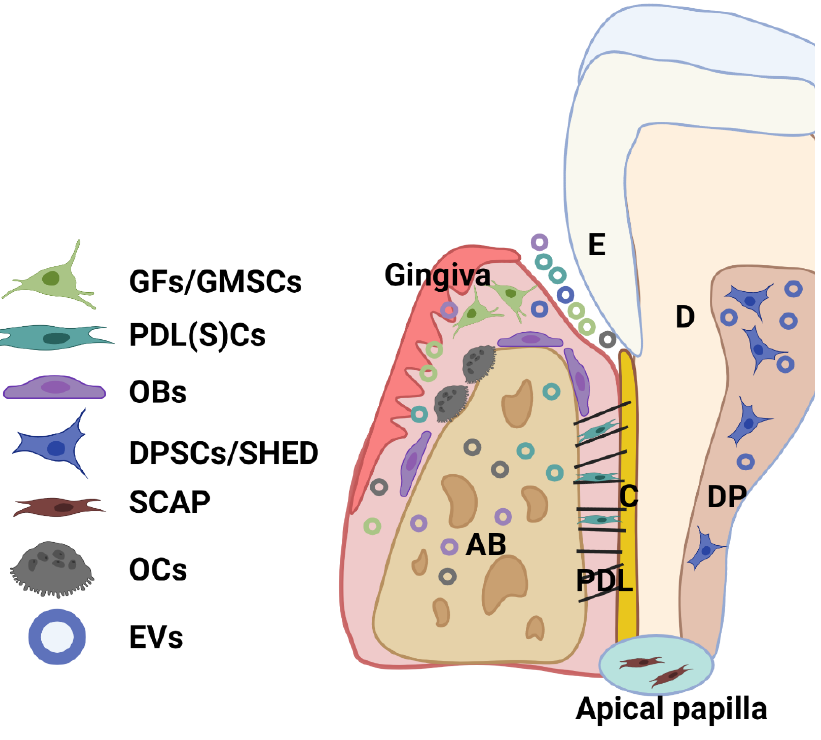
Figure 2. Schematic showing the main cell population and cell products (EVs) within a healthy periodontium. Various cells reside in the periodontium, such as periodontal ligament (stem) cells (PDLSCs), fibroblasts (GFs) and stem cells (GMSCs) from the gingiva, osteoblasts (OBs), osteoclasts (OCs), and various immune cells. AB: alveolar bone; C: cementum; D: dentin; DP: dental pulp; PDL: periodontal ligament; SHED: dental pulp cells from human exfoliated deciduous teeth (SHED); SCAP: cells from periodontal apical papilla tissues (SCAP).